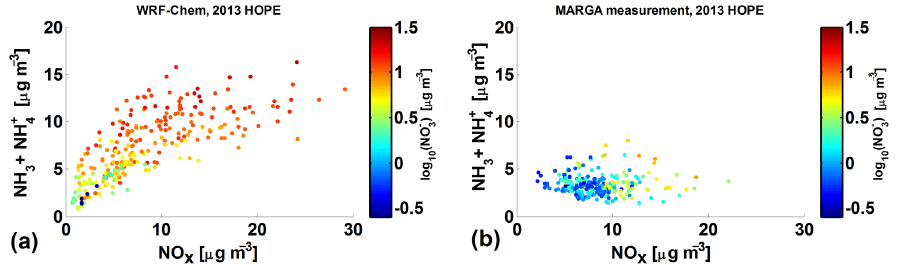
Figure 9. Relationship between nitrate, total ammonia and NO x during 10–20 September 2013 at Melpitz. The color indicates the nitrate mass concentration in logarithmic scale. (a) WRF-Chem model results; (b) MARGA measurement